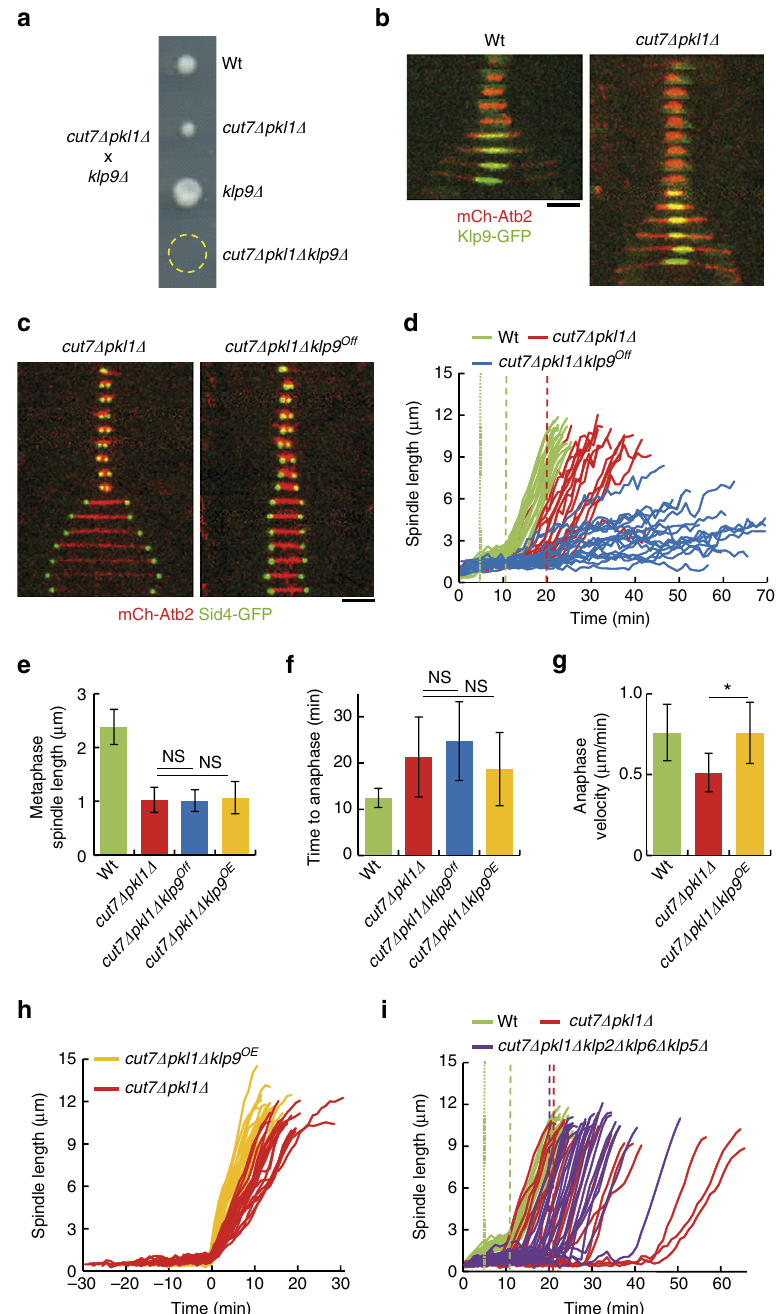
Figure 2 | Klp9 is not essential for spindle assembly in cut7 D pkl1 D cells. ( a ) Tetrad dissection of cut7 D pkl1 D cells crossed to klp9 D cells. ( b ) Time-lapse images of wild-type (wt) and cut7 D pkl1 D cells expressing mCherry-Atb2 and Klp9-GFP from mitosis onset to spindle breakdown. Each frame corresponds to 3min interval. ( c ) Time-lapse images of cut7 D pkl1 D and cut7 D pkl1 D klp9 Off cells expressing mCherry-Atb2 and Sid4-GFP from mitosis onset to spindle breakdown, after 8h of repression/shut-off. Each frame corresponds to 3min interval. ( d ) Comparative plot of spindle length dynamics cut7 D pkl1 D (red curves; n ¼ 16) and cut7 D pkl1 D klp9 Off cells (blue curves; n ¼ 18) after 8h of repression/shut-off. Dotted vertical line corresponds to phase I–II transition; dashed vertical line corresponds to phase II–III transition. ( e ) Bar plot showing metaphase spindle length at anaphase transition, reported by Cdc13-GFP degradation, of wild-type (green; n ¼ 43), cut7 D pkl1 D (red; n ¼ 36), cut7 D pkl1 D klp9 Off cells after 8h repression/shut-off (blue; n ¼ 26), and cut7 D pkl1 D klp9 OE cells after 20h of overexpression induction (orange; n ¼ 37). ns, not statistically significant. ( f ) Bar plot showing anaphase transition time of wild-type (green; n ¼ 43), cut7 D pkl1 D (red; n ¼ 36), cut7 D pkl1 D klp9 Off cells after 8h incubation in thiamine-containing medium (blue; n ¼ 26) and cut7 D pkl1 D klp9 OE cells after 20h of overexpression induction (orange; n ¼ 37). NS, not statistically significant. ( g ) Bar plot showing anaphase spindle elongation velocity of wild-type (green; n ¼ 29), cut7 D pkl1 D cells (red; n ¼ 22) and cut7 D pkl1 D klp9 OE cells after 20h of overexpression induction (orange; n ¼ 29). * P o 0.001. ( h ) Comparative plot of spindle length dynamics of cut7 D pkl1 D (red curves; n ¼ 20) and cut7 D pkl1 D klp9 OE cells (orange curves; n ¼ 20) after 20h of overexpression induction. Time 0 represents the start of anaphase elongation. ( i ) Comparative plots of spindle length dynamics of cut7 D pkl1 D (red curves; n ¼ 22) and cut7 D pkl1 D klp2 D klp6 D klp5 D cells (purple curves; n ¼ 22). Dotted vertical line corresponds to phase I–II transition; dashed vertical line corresponds to phase II–III transition. Data show mean ± s.d. and Student’s t -test P value. Scale bars, 2 m m. NATURE COMMUNICATIONS|8:15286|DOI: